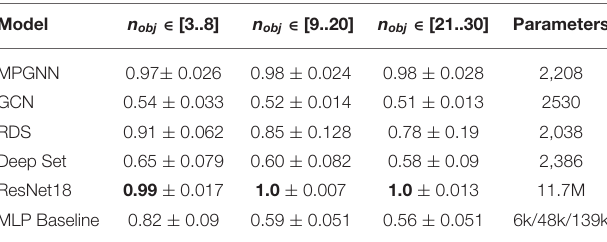
TABLE 1 | Test classification accuracies (means and standard deviations are given over datasets and seeds) for the three different models on the Identification task.